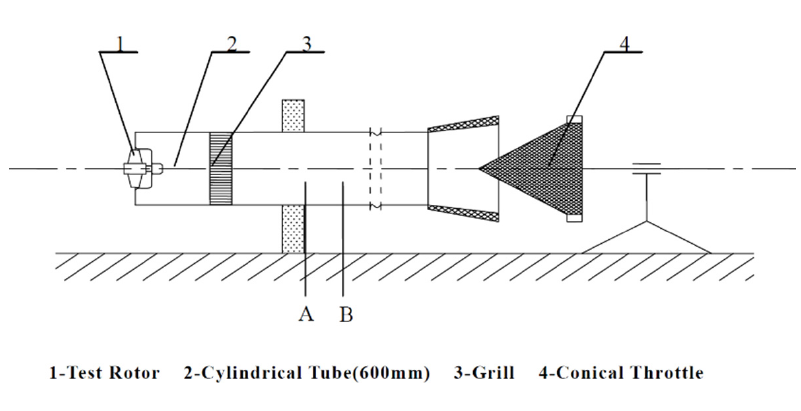
Figure 11. The experiment of Blade D500.